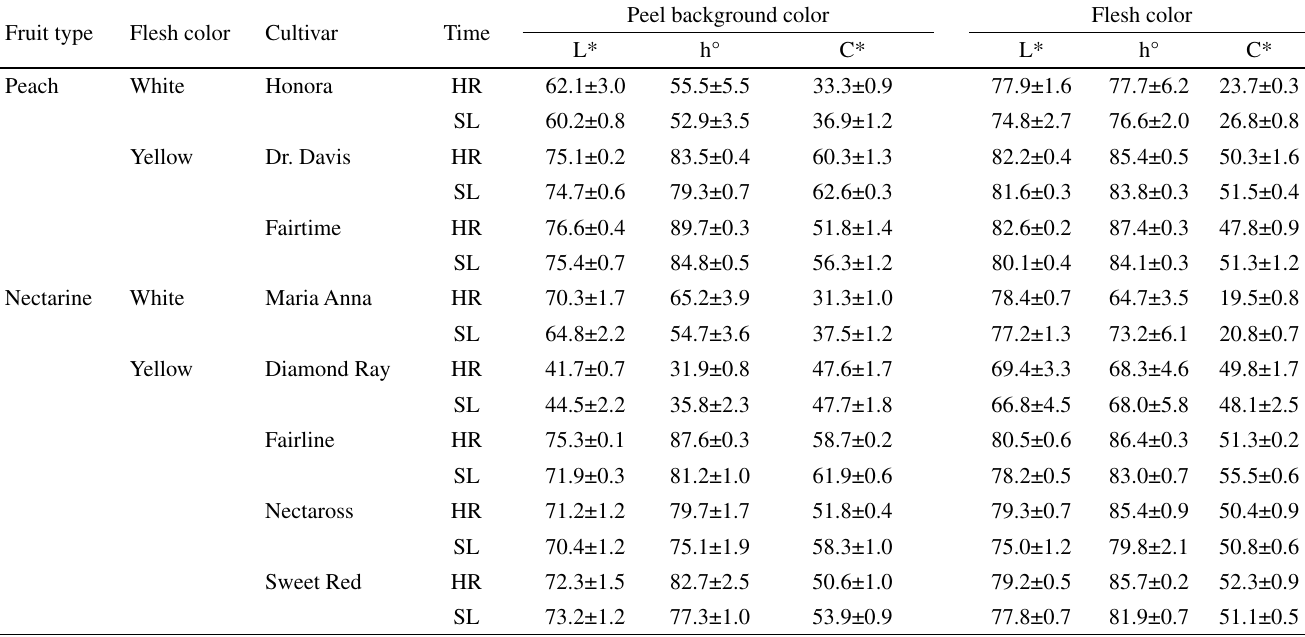
Table 2 - Peel and flesh color parameters (means ±standard error) of peach and nectarine cultivars at harvest (HR) or after five days of shelf-life (SL) at